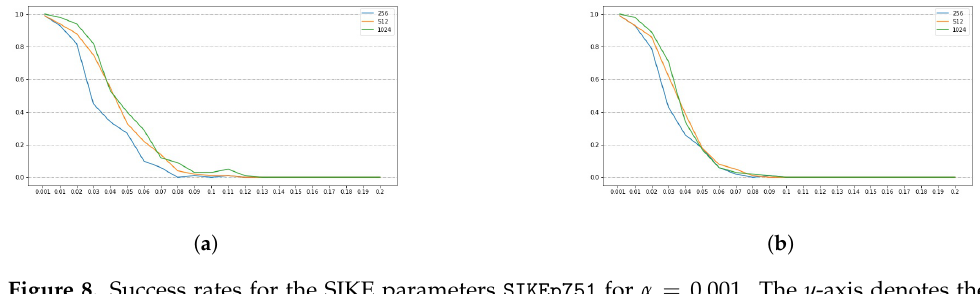
0.001,0.01,0.02, . . . ,0.2 . ∈ { }